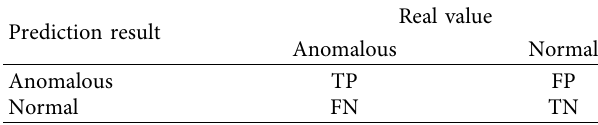
Table 2: The confusion matrix of the binary classification problem.